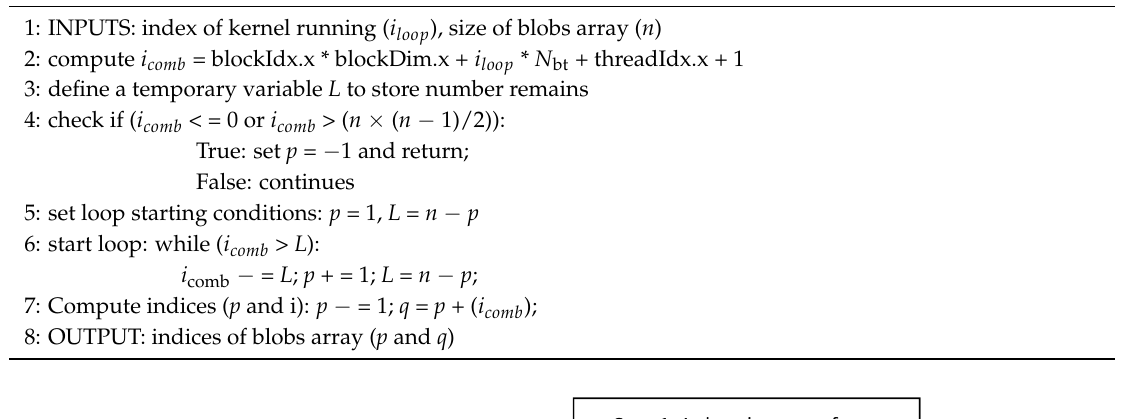
Algorithm 1. Pseudocode for locating blobs for each thread.